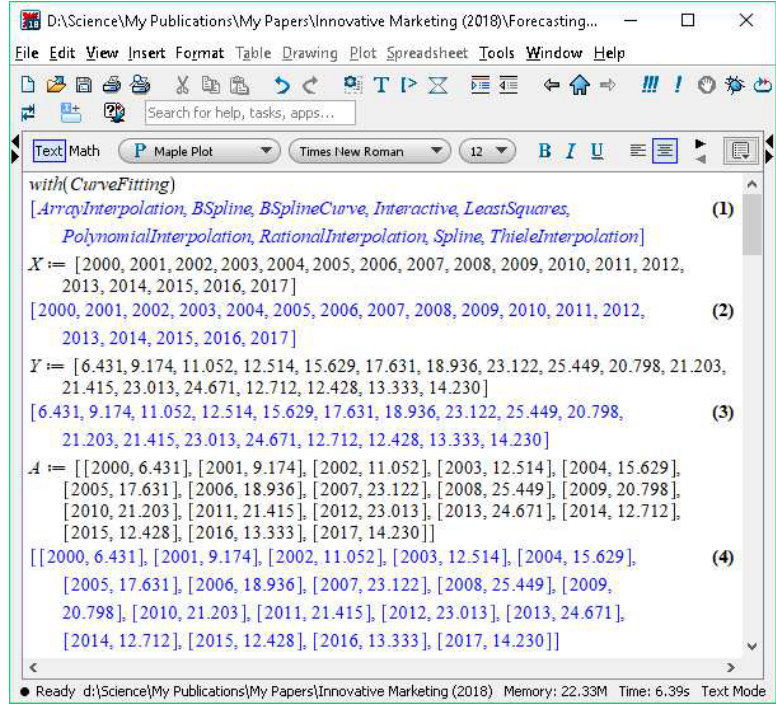
Figure A1. Creating the matrices of data in Maple